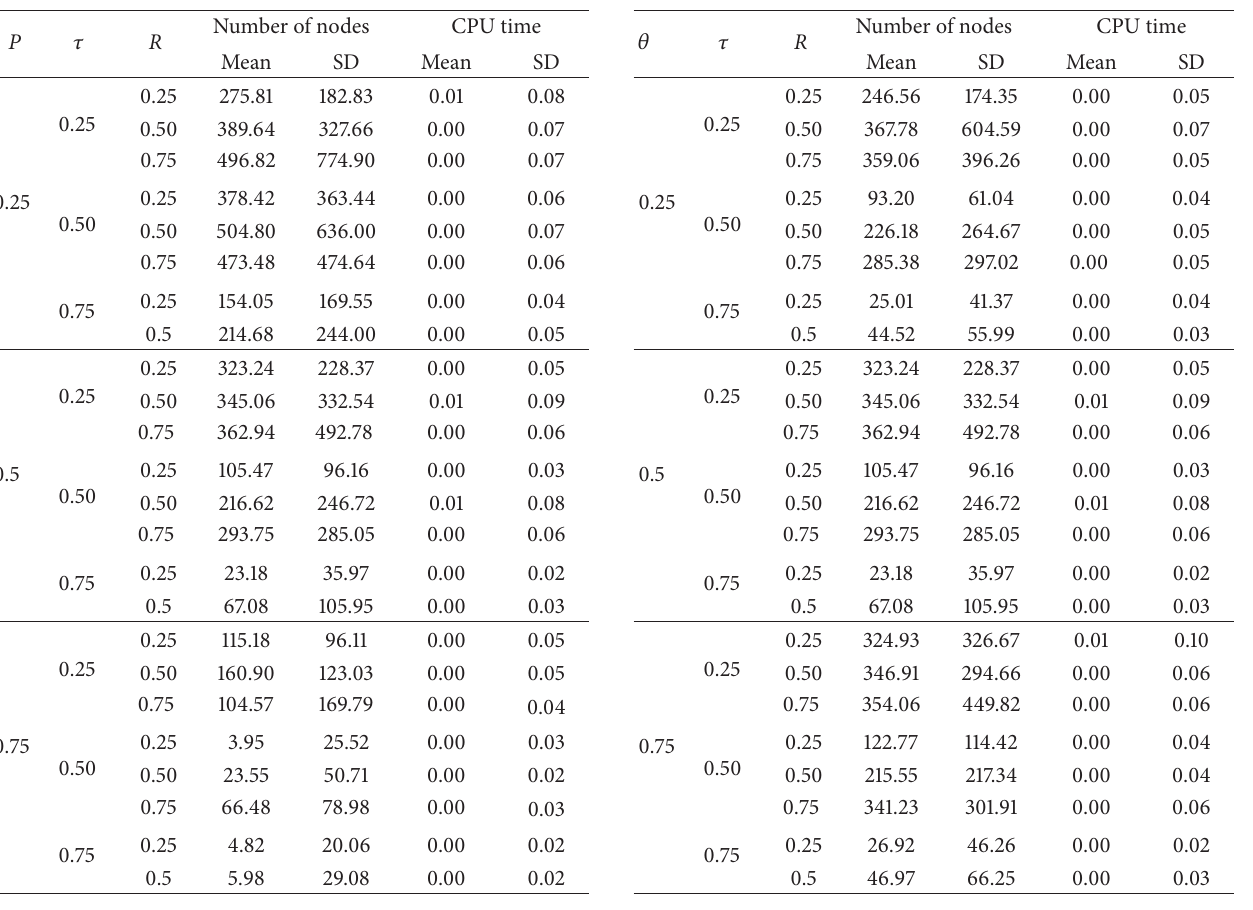
Table 3: The performance of the B&B with 𝑛 = 12 and 𝑃 = 0.5 .